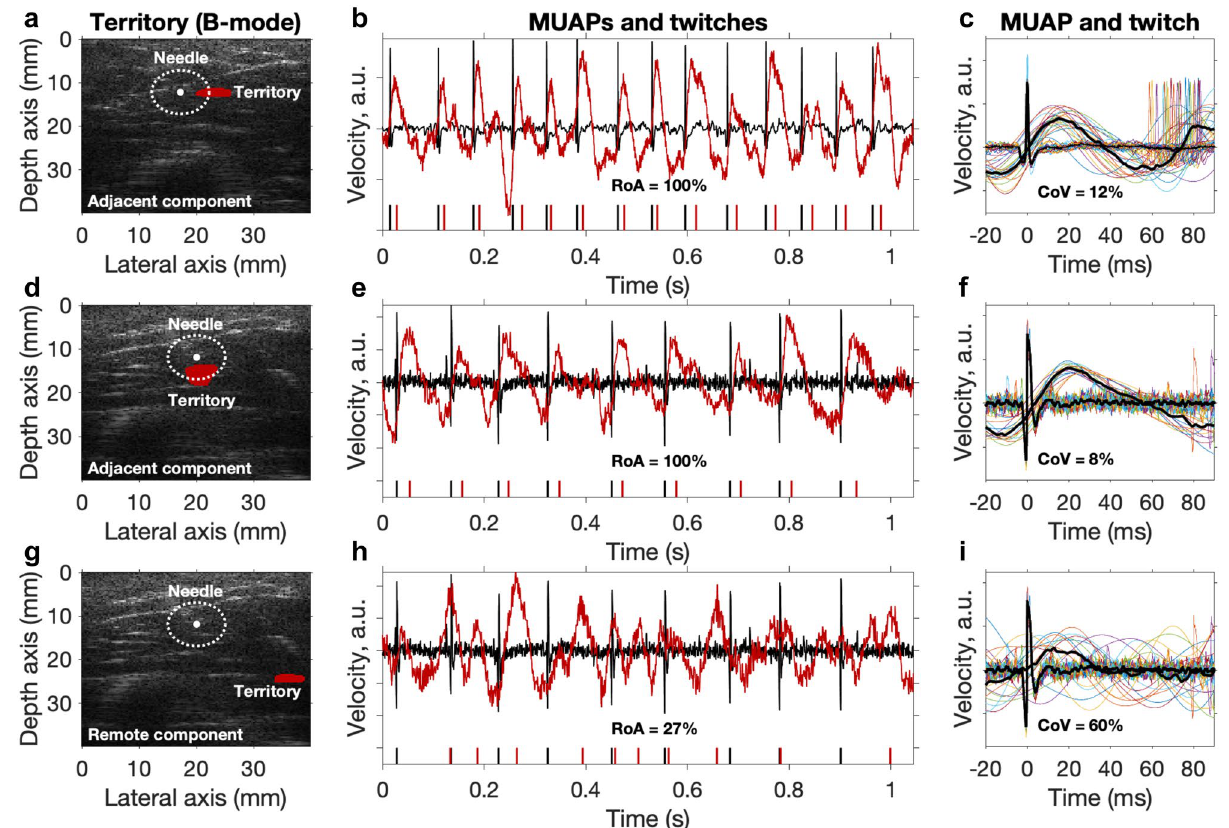
Figure 3. Three examples of decomposed components (territory and twitches) from ultrafast ultrasound together with MUAPs from EMG. The first two rows ( a – c , d – f ) are adjacent components and the last row ( g–i ) is the corresponding remote component to ( d–f ). ( a , d , g ) Components’ MU territory (red region) of biceps brachii cross-section and the concentric needle uptake area (white dotted circle). ( b , e , h ) The MUAPs (black), components’ twitches (red), and their corresponding firing patterns below (black and red vertical lines). ( c , f , i ) The spike-triggered averaged mechanical twitches given the MU firing pattern (from